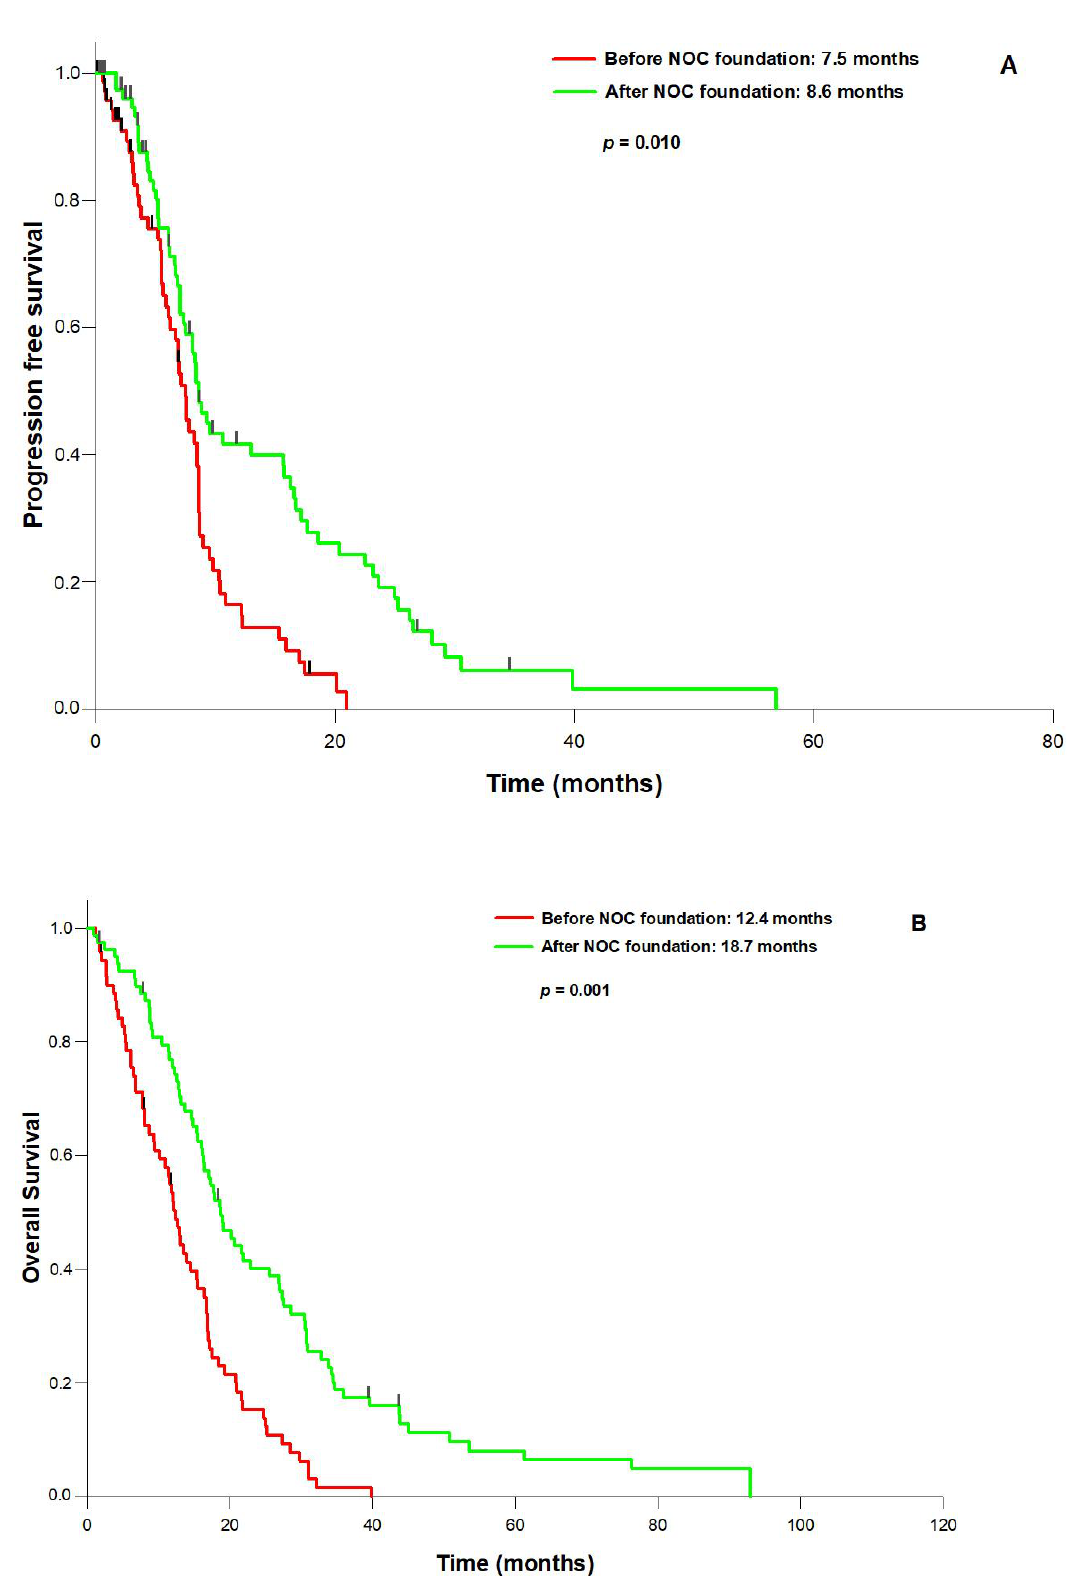
Figure 3. Outcome before and after the NOC foundation: ( A ): progression-free survival and ( B ): overall survival is significantly longer in the subcohort treated after the NOC foundation.